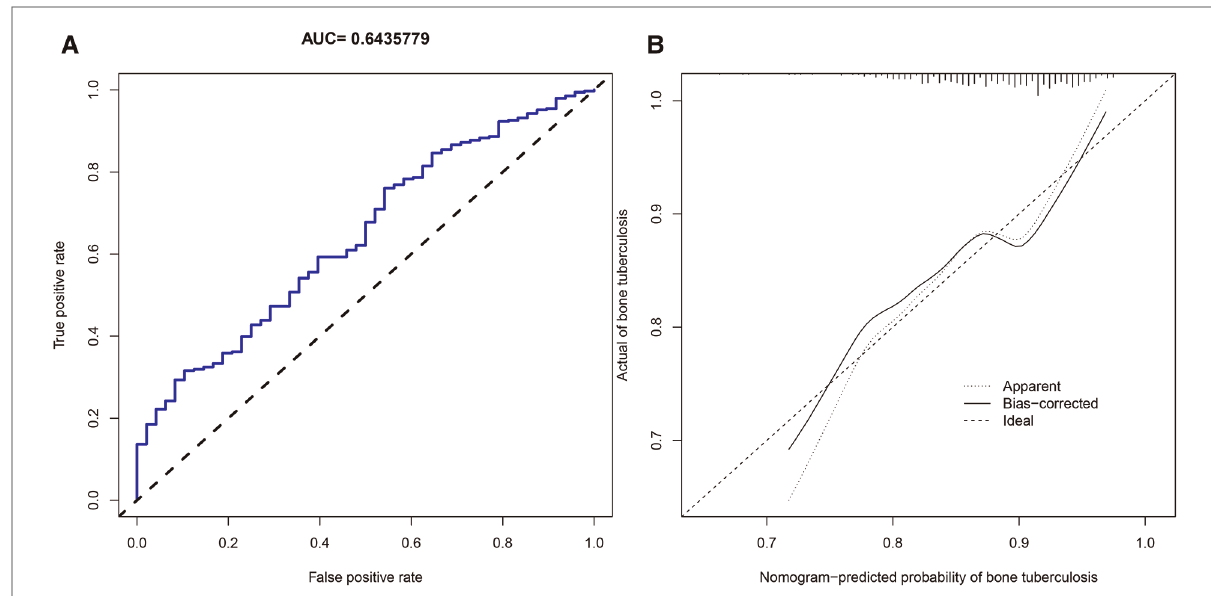
FIGURE 7 Validation cohort. ( A ) AUC values of the diagnostic model of bone and joint TB in the validation cohort. ( B ) Calibration curves for predicting bone and joint TB in the validation